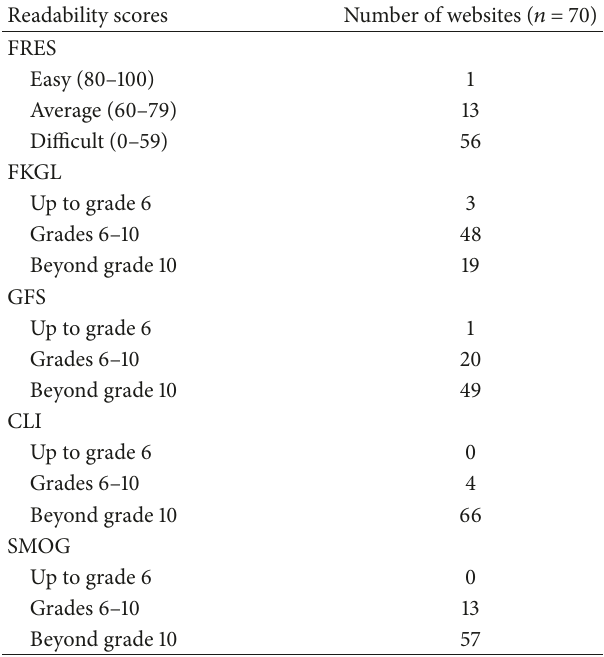
Table 6: Category breakdown of readability scores of health infor- mation